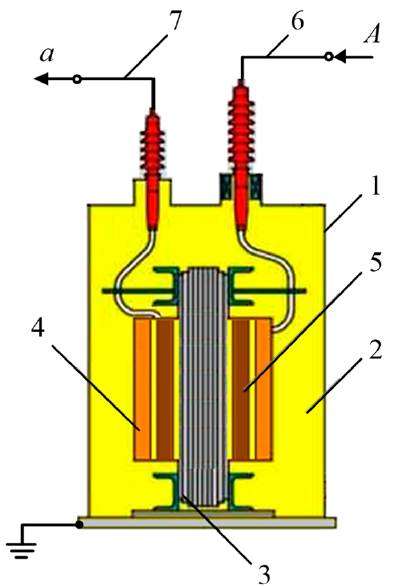
Figure 1. Structure flowchart of a high-voltage oil-filled power transformer.